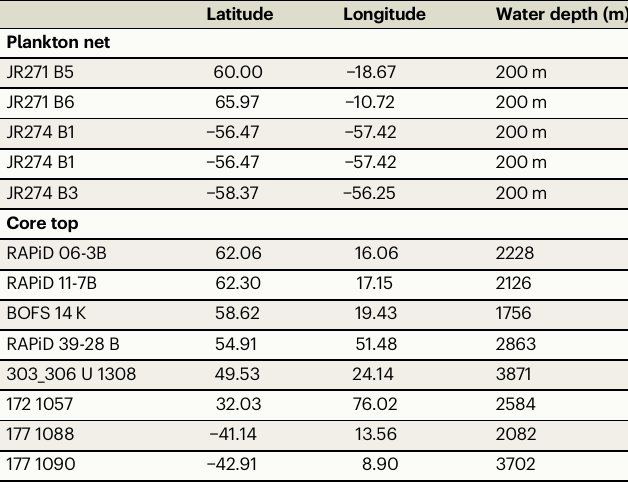
Table 1 | Site location details Table 2 | Main results; bulk sediment δ 13 C org , planktonic